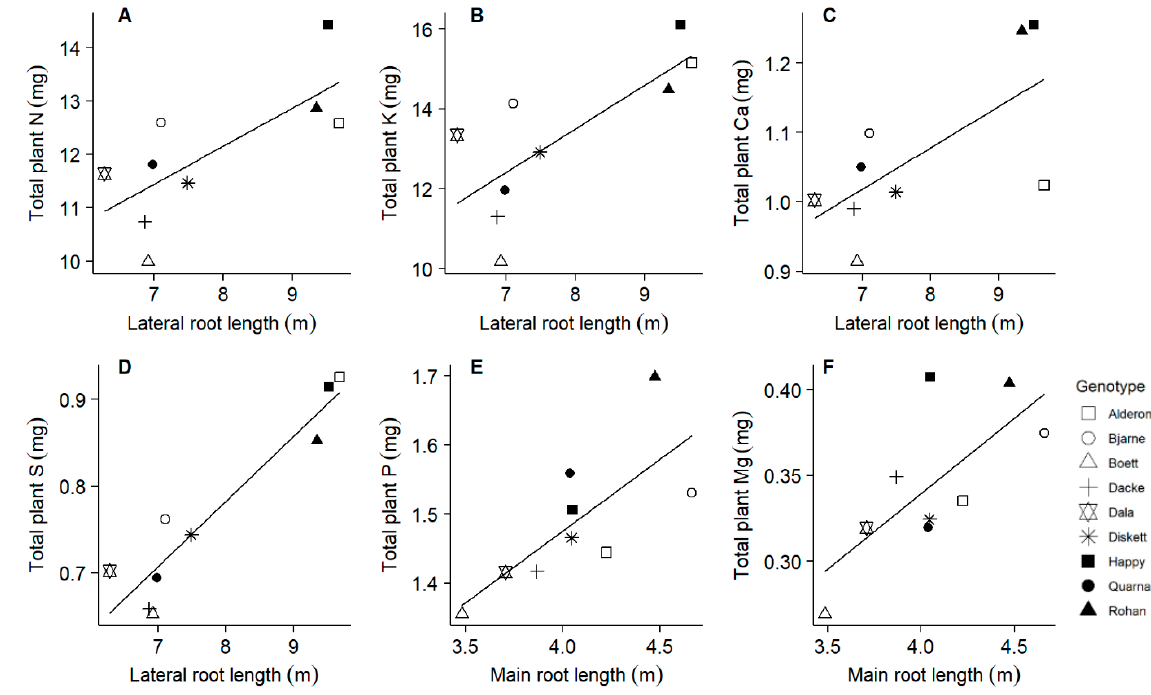
Figure 4. Relationships between root length and the pools of macronutrients in whole plants at day 20. Root length was measured destructively with a scanner at day 20. Linear regressions: ( A ) r 2 = 0.532, p = 0.026; ( B ) r 2 = 0.573, p = 0.018; ( C ) r 2 = 0.460, p = 0.045; ( D ) r 2 = 0.887, p < 0.001; ( E ) r 2 = 0.558, p = 0.021; ( F ) r 2 = 0.516, p = 0.029.